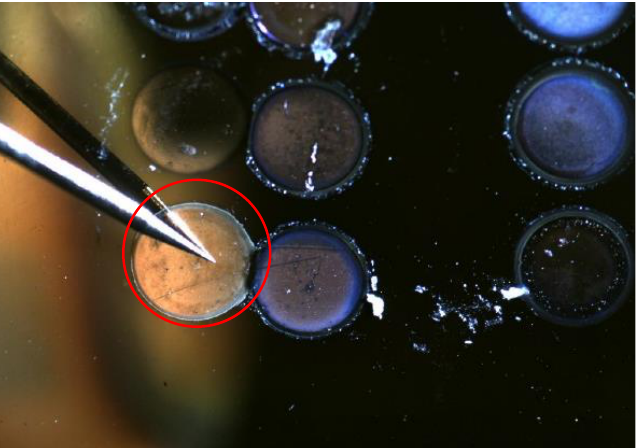
Figure 3. Camera sample image of an in-situ contact of an all-solid state lithium thin-film battery (red circle) using a W contact needle (silver part on the left) attached to an isolated 2 pole DC feedthrough (not shown) with an outside cell tester. The cell to source wiring accounts to 1 Ω DC resistance.